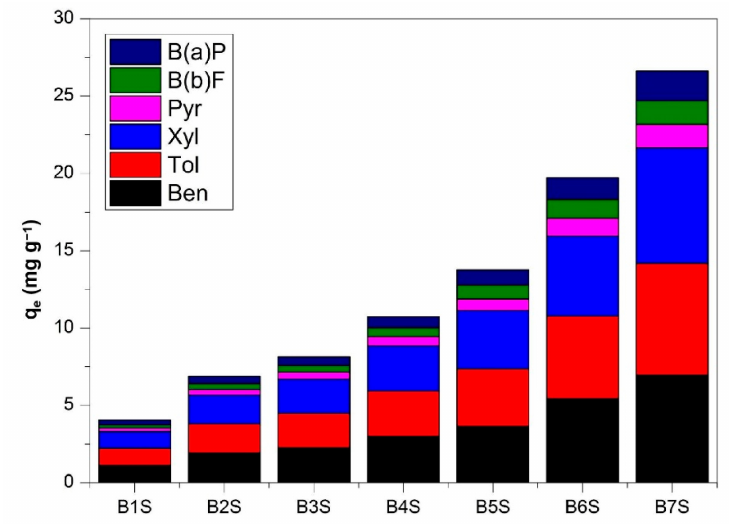
Figure 11. Dependence of adsorption capacity of MTMS-aerogel on the initial concentration of different mixtures